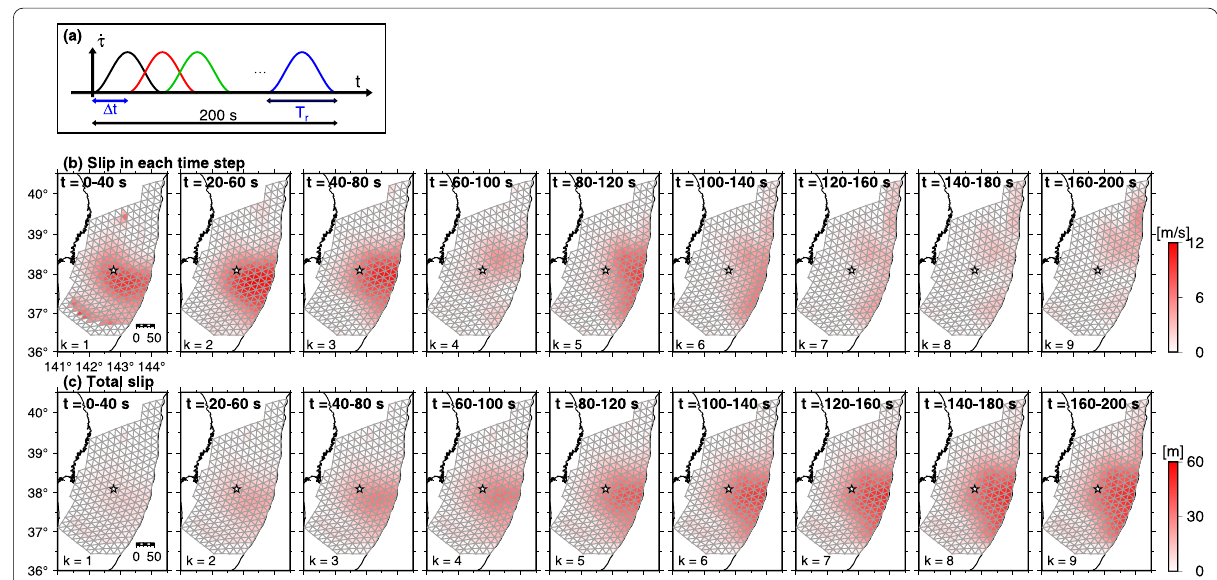
Fig. 5 Temporal evolution of the slip. a Configuration of the temporal elements of the inversion analysis. b Slip amount of the subfaults in each temporal element. b Temporal evolution of the total slip amount, calculated by the summation of the temporal